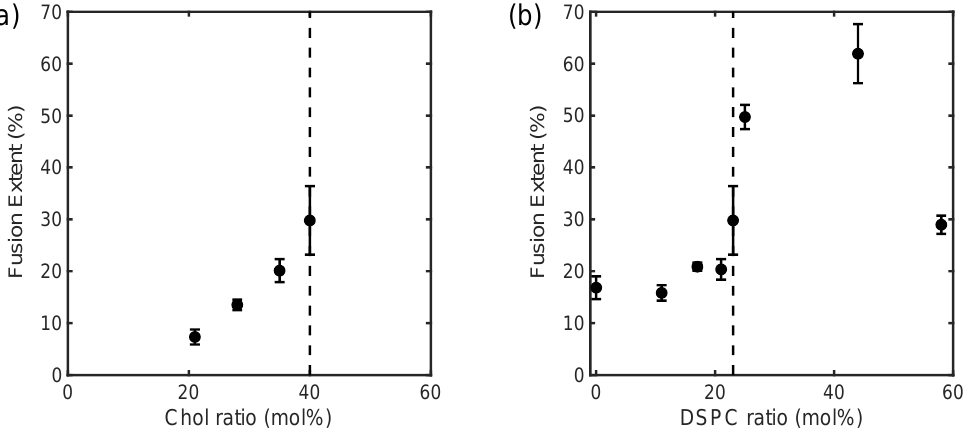
Figure 4. Fusion extent for the ( a ) laterally heterogeneous and ( b ) homogeneous membranes as a function of composition at 23 °C. The compositions are designated by their ( a ) Chol and ( b ) DSPC contents. Detailed compositions are given in Table 1. Dash lines mark the critical composition. The measurements were repeated at least triply with independently prepared